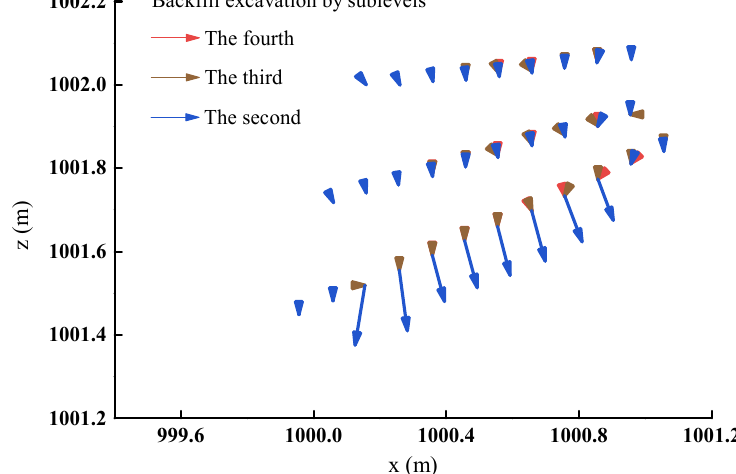
Figure 7. Displacement vector of backfill excavation in each sublevel.